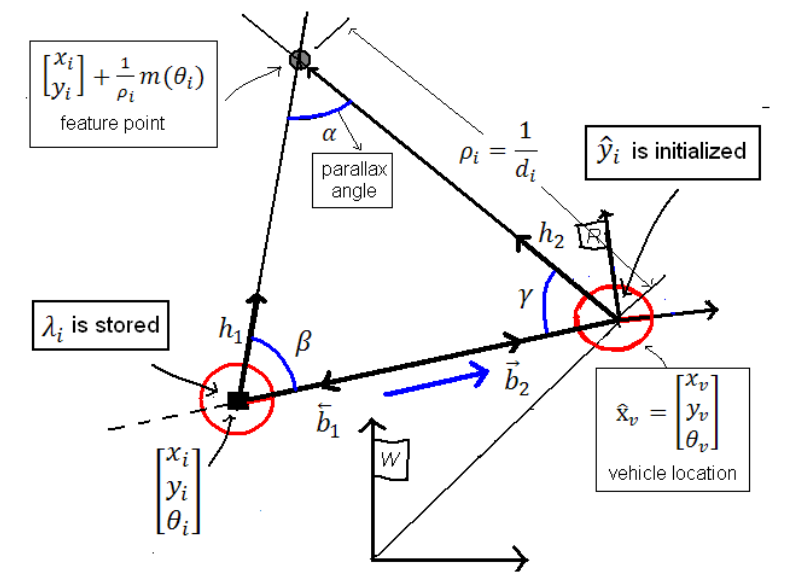
Figure 4. ID-Delayed